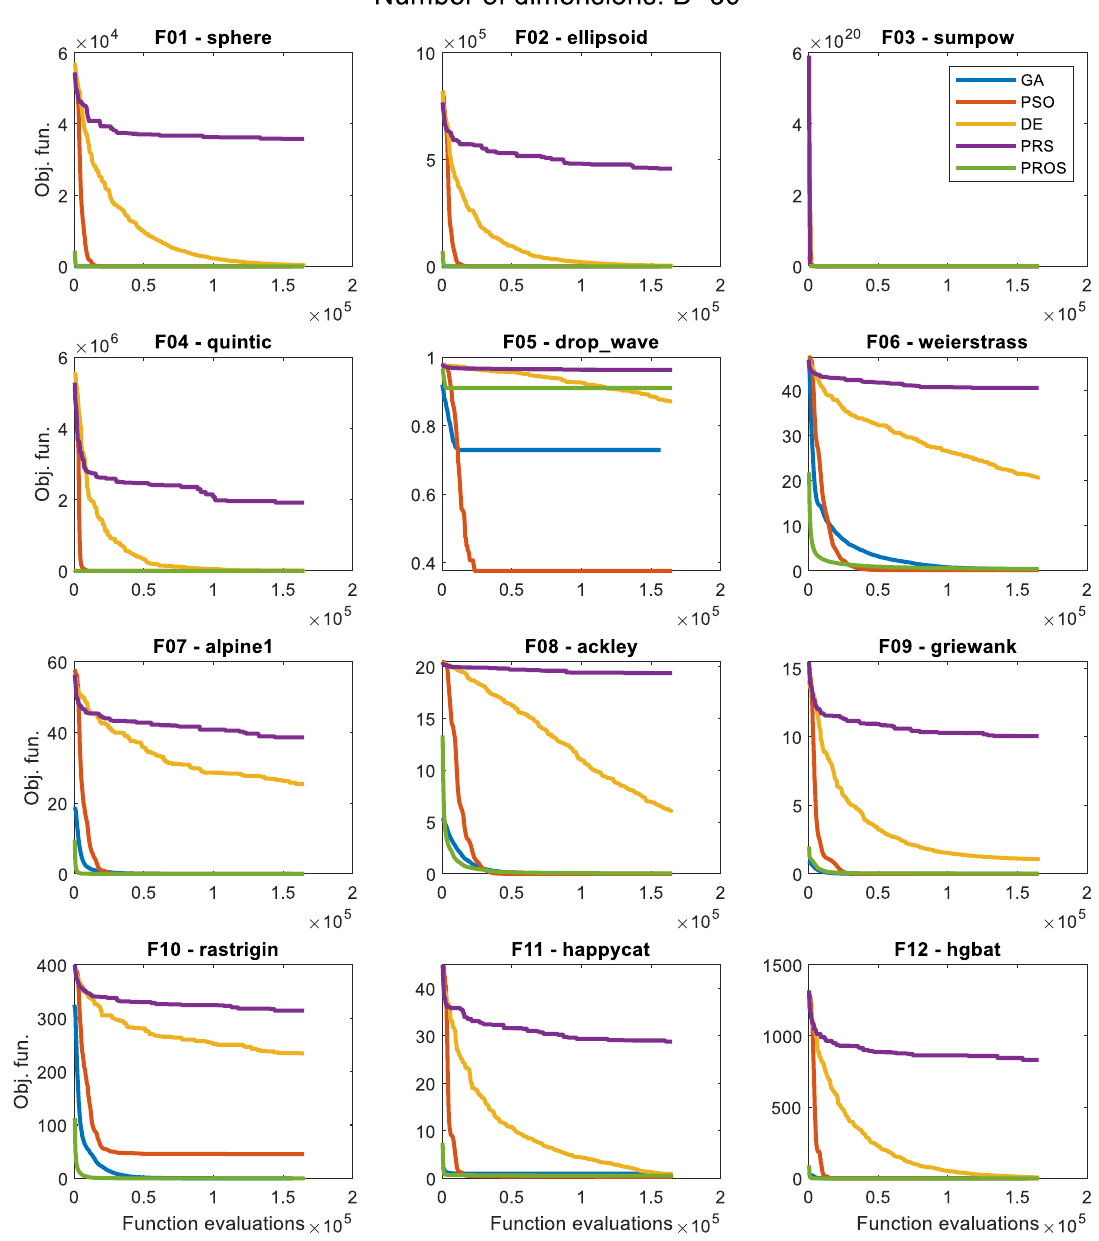
Figure 7. Convergence history of the various optimizers for 30 dimensions ( D = 30), for all 12 objective functions (average of 10 runs).